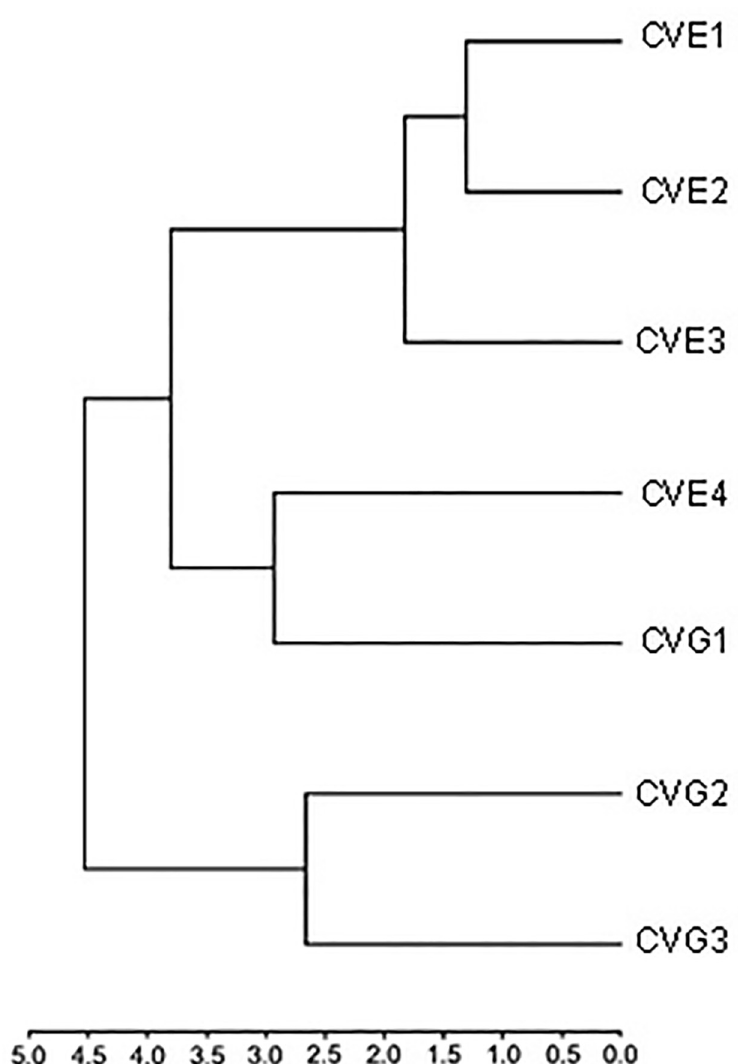
Fig 9. UPGMA dendrogram of C . vicina wing morphological proximity constructed based on the Mahalanobis distances from canonical variate analysis between Germany (CVG1, CVG2, CVG3) and England (CVE1, CVE2, CVE3,